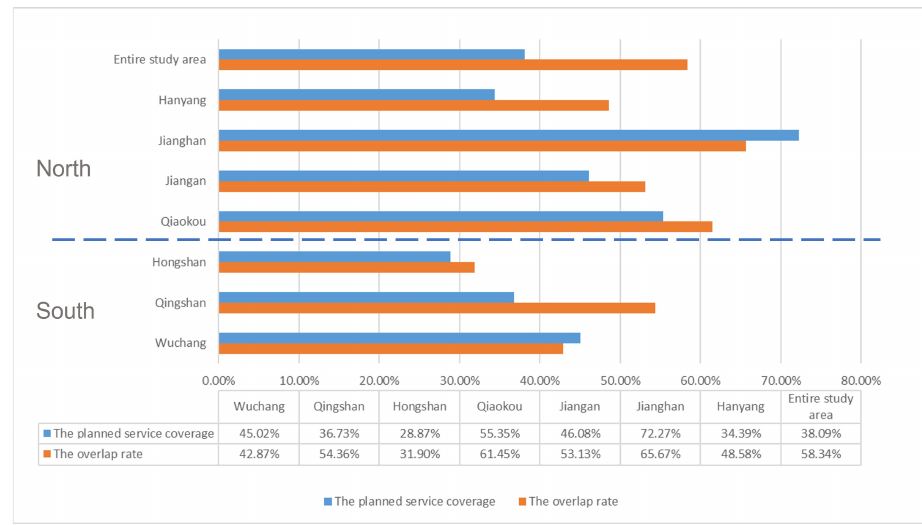
Figure 5. Chronic disease pharmacy service coverage and overlap based on planning radius.